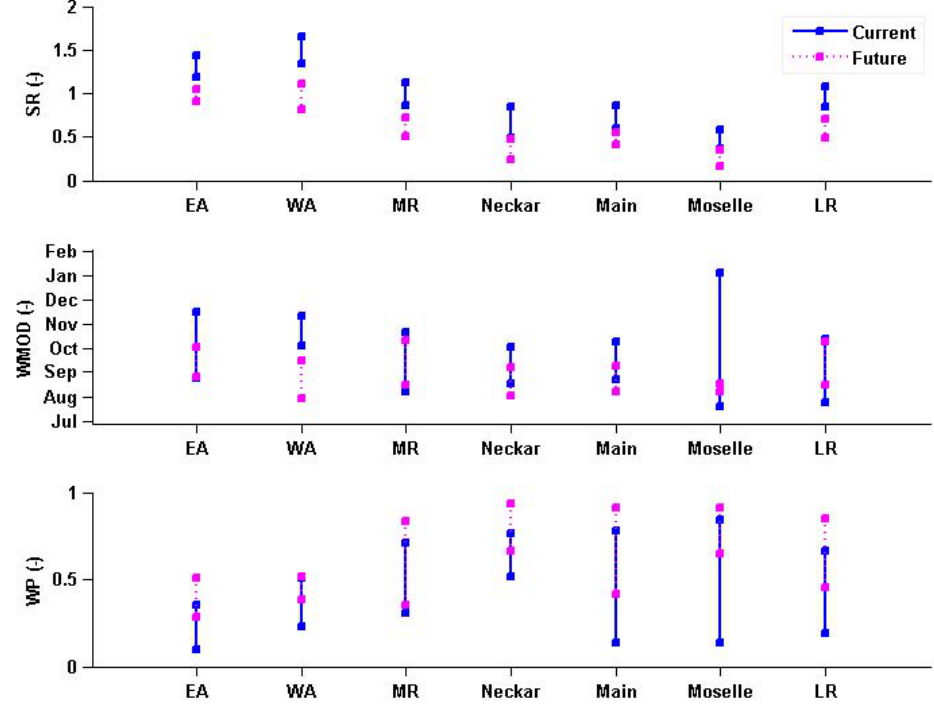
Fig. 5. Range (shown as bar) of three seasonality indices in the seven sub-basins for the current climate (calculations for case 3) and future climate (calculations for case